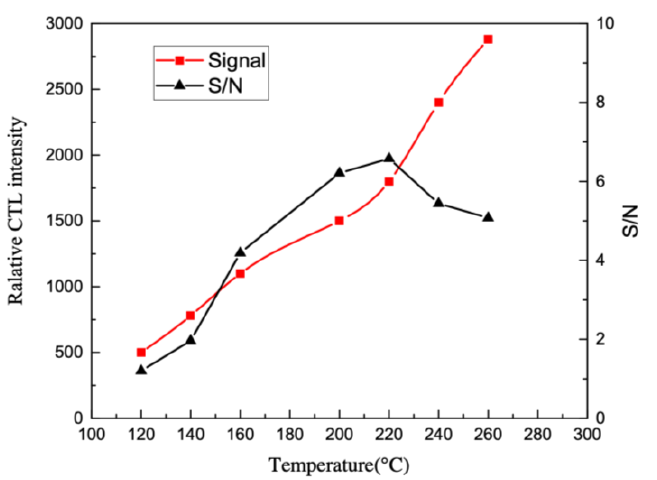
Figure 8. The luminescence intensity of acetone changed with different temperatures (wavelength: 590 nm, flow rate: 310 mL/min, concentration: 200 ppm).